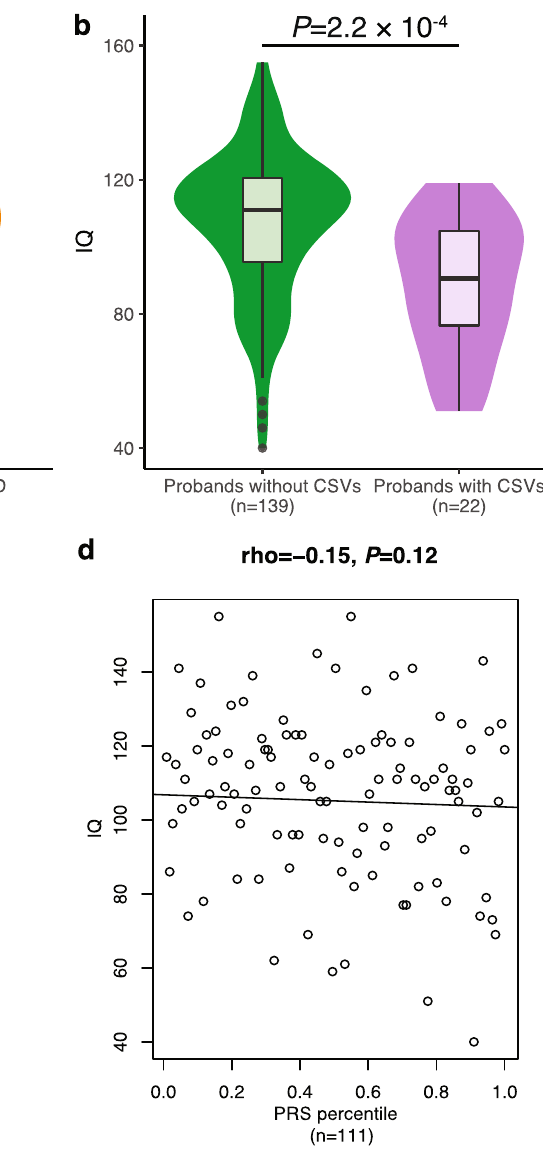
greater than dysmorphic ASD or probands with CSVs, respectively (one-sided, Welch ’ s t -test).CorrelationbetweenIQand( c )GRVSand( d )PRSisshown. c , d Each dotrepresentstheIQandGRVSorPRSpercentileofasample.Thelinearregression line indicates the linear correlation between IQ and GRVS or PRS percentiles. Correlation coef fi cient is quanti fi ed by two-sided Spearman ’ s rho correlation. P values indicate the probability that the correlation is occurred due to chance. Source data are provided as a Source Data fi